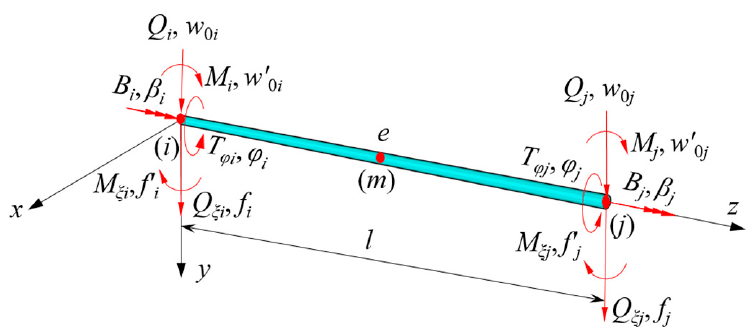
Figure 6. Asimply supported beam.